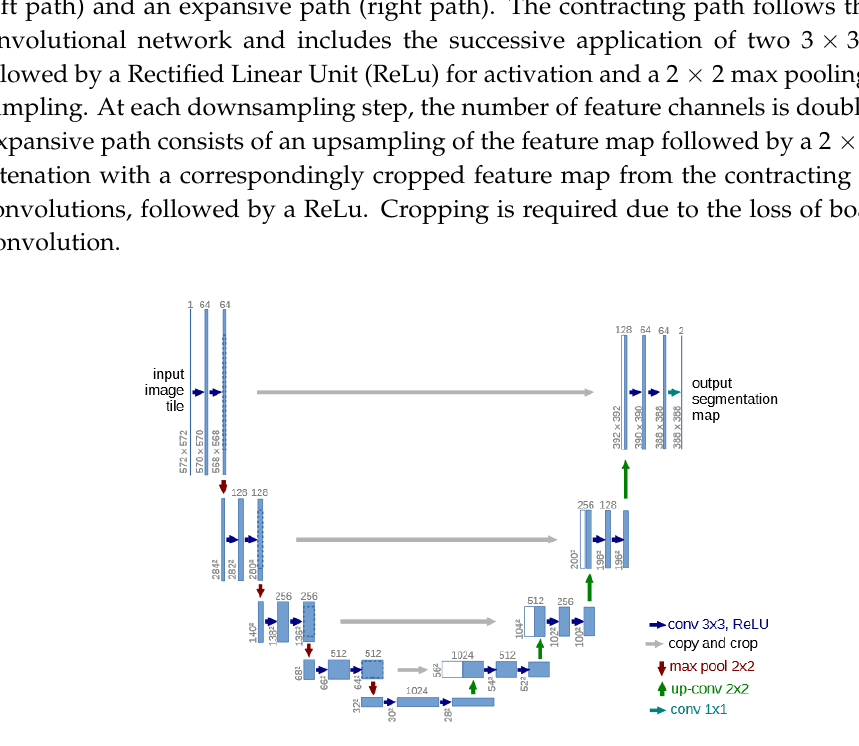
Figure 4. U-Net architecture example for 32 × 32 pixels in the lowest resolution. Each blue box corresponds to a multi-channel feature map. The number of channels is denoted on top of the box. The xy -size is provided at the lower left edge of the box. White boxes represent copied feature maps. The arrows denote the different